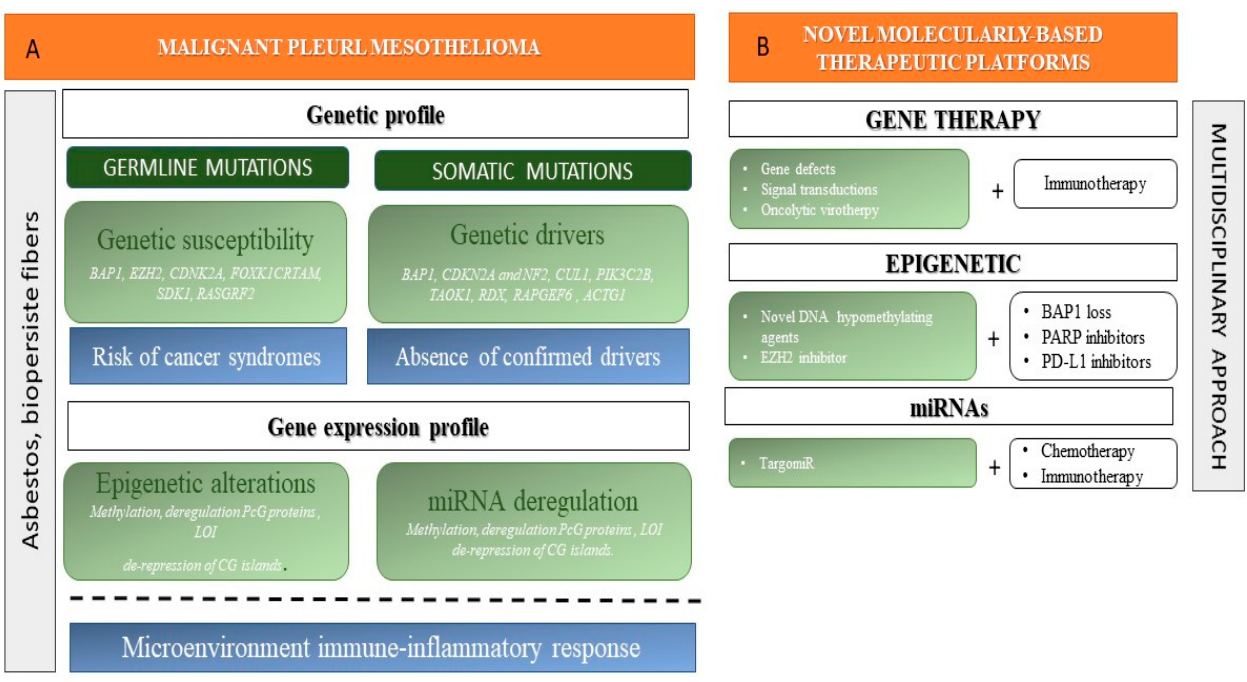
Figure 1. Malignant pleural mesothelioma (MPM): Pathogenic mechanisms and therapeutic platforms . ( A ) Main players involved in MPM onset. ( B ) Novel therapeutic strategies designed on the basis of disease molecular features.